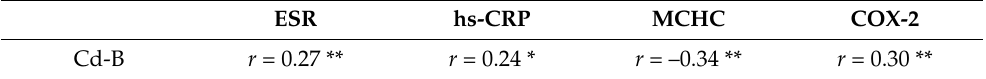
Table 4. Correlations between Cd-B and laboratory parameters in the study population.